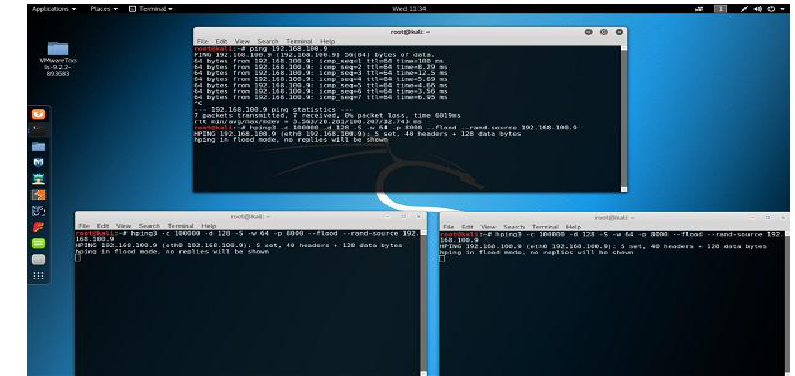
Figure 5 – Starting attacks from multiple terminals